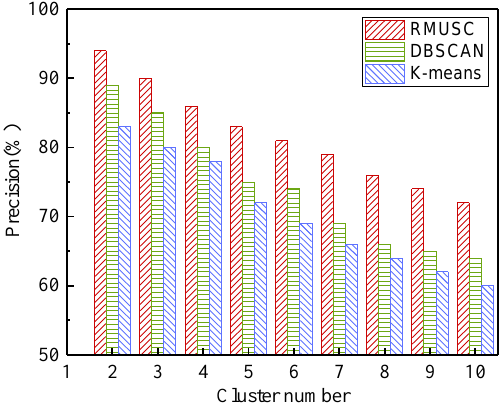
Figure 5. Performance comparisons of clustering algorithms on precision.